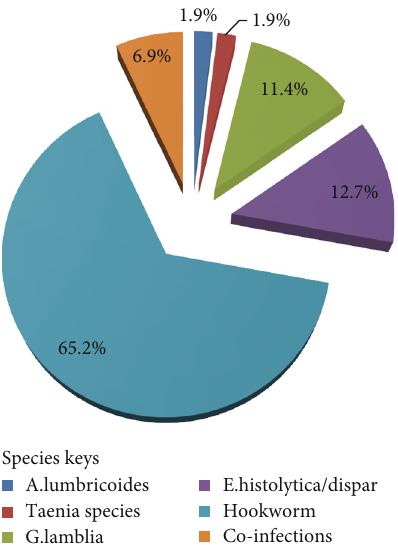
Figure 1: Relative proportion of intestinal parasites among pregnant women in Debre Elias District, March 2021-July